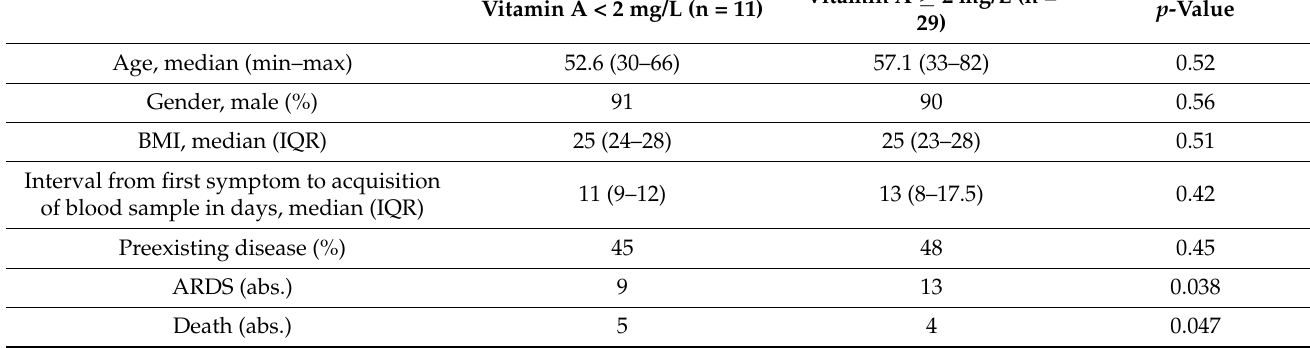
Table 2. Clinical outcomes and inflammation parameters based on vitamin A plasma levels; differences were calculated using the Mann–Whitney U test or Fisher’s exact test (both 2-tailed); SAPS II = Simplified Acute Physiology Score II; BMI = body mass index; ARDS = acute respiratory distress syndrome; IQR = interquartile range; LDH = lactate dehydrogenase; PCHe = pseudocholinesterase, ALT = alanine